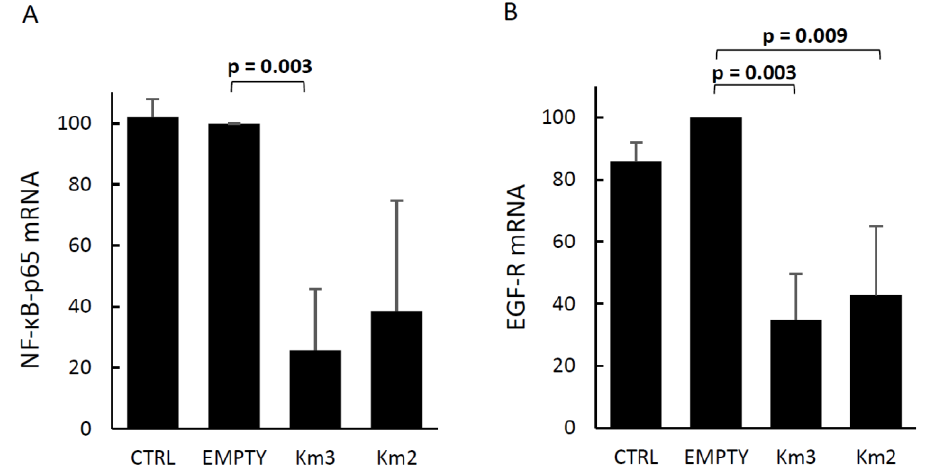
Figure 3. Levels of epidermal growth factor receptor (EGF-R) and nuclear factor kappa-light-chain- enhancer of activated B cells (NF- κ B) p65 mRNAs in LNCaP cells transfected either with the empty plasmid or with the pX601-Km3 or Km2 gRNA plasmids. The same cDNAs and protein extracts used for the assays reported in Figure 2 were used. ( A ) Mean levels of EGF-R mRNA. ( B ) Mean levels of NF- κ B p65 mRNA. Data are the means of the percent values with respect to those of empty-treated cells in each of three experiments, run in duplicate. For controls of specificity, see Methods.